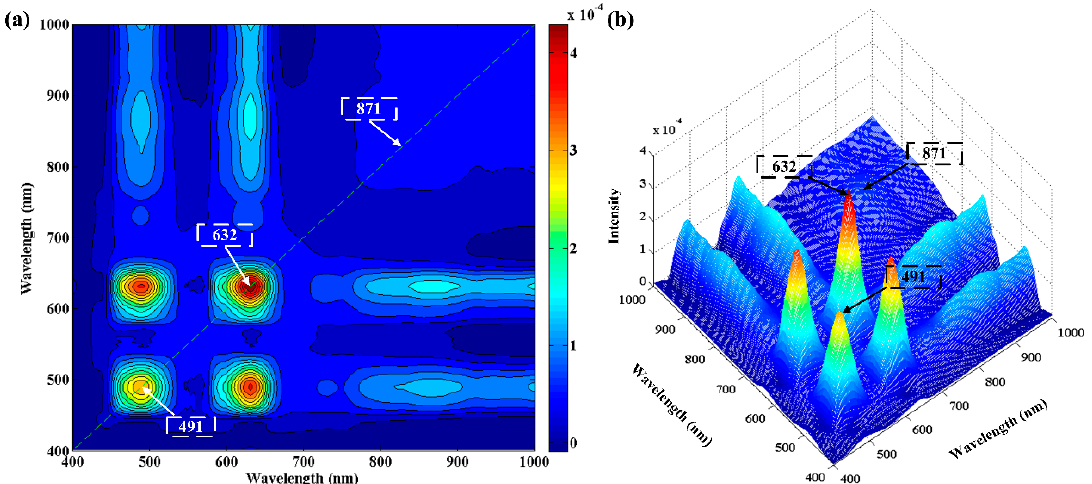
Figure 3. The 2D-COS spectrum of samples with various adulteration levels. ( a ) Synchronous contour map plot, ( b ) Corresponding synchronous 3D stereo plot.